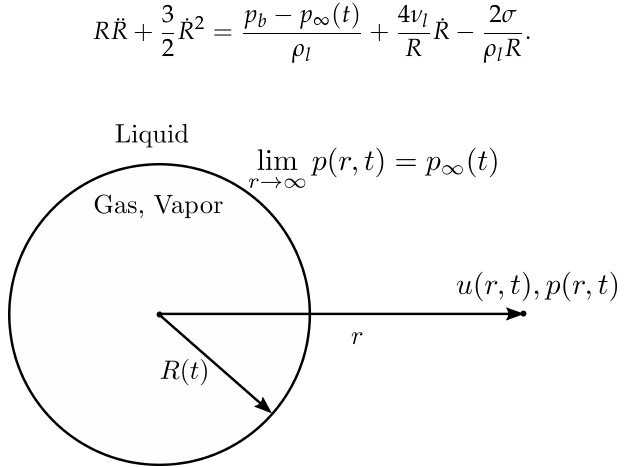
Figure 3. Schematic of a spherical bubble in an infinite fluid